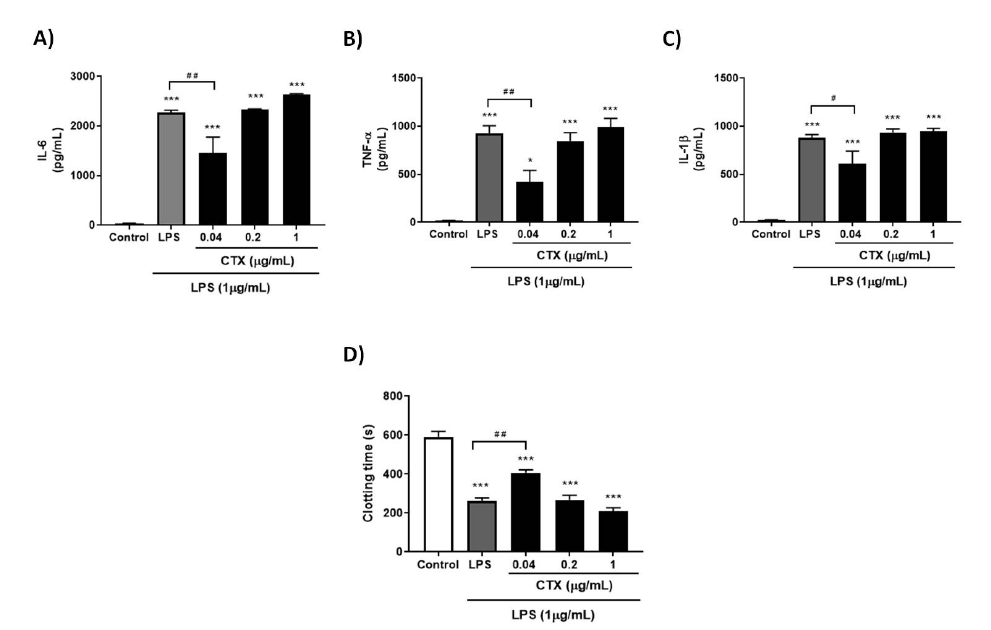
Figure 5. Anti-inflammatory and anticoagulant behavior of CTX on whole blood. Whole blood treated with medium only (control), LPS (1 µg/mL) or different concentrations of CTX (1, 0.2 or 0.04 µg/mL) 30 minutes before exposure to LPS, for 24 hours. From the supernatant, the pro-inflammatory cytokines (A) IL-6, (B) TNF-α and (C) IL-1β were quantified, and the remaining cells were submitted to the (D) procoagulant activity assay from the isolated PBMCs. Results were expressed as mean cytokine concentration (pg/mL) ± SEM and mean clotting time (s) ± SEM. Experimental groups were performed with n = 6. ***p < 0.001 and *p < 0.05 vs. control, and ## p < 0.01 and # p < 0.05 vs. LPS. Statistical analysis was performed using one-way ANOVA followed by Dunnett’s